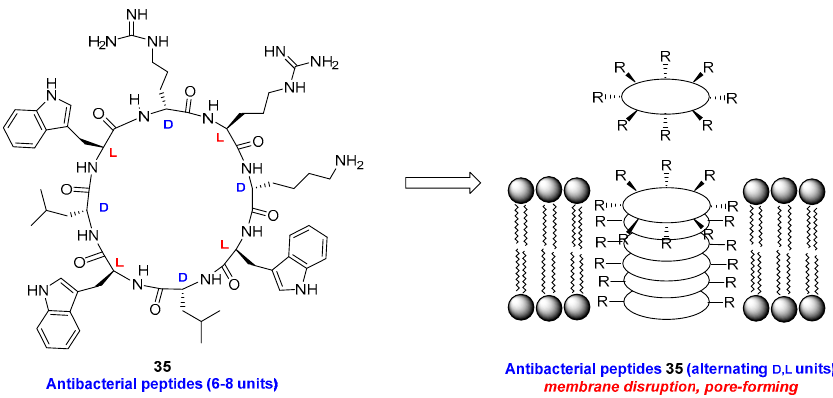
Figure 5. Cyclic peptides with alternating D, L -units self-assemble and form pores in the bacterial membrane.